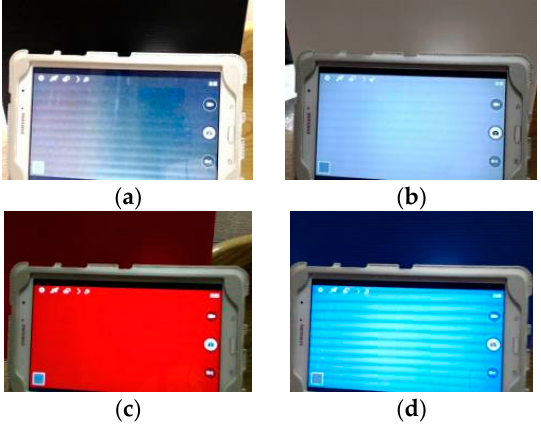
Figure 4. The four kinds of original color image. Original image of the displayed color for ( a ) black; ( b ) white; ( c ) red; and ( d ) blue.